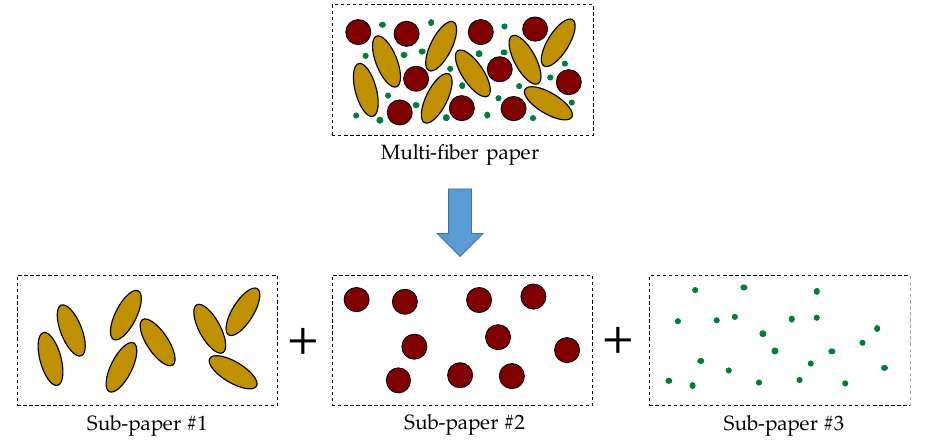
Figure 9. Schematic of multi-fiber paper and sub-papers.